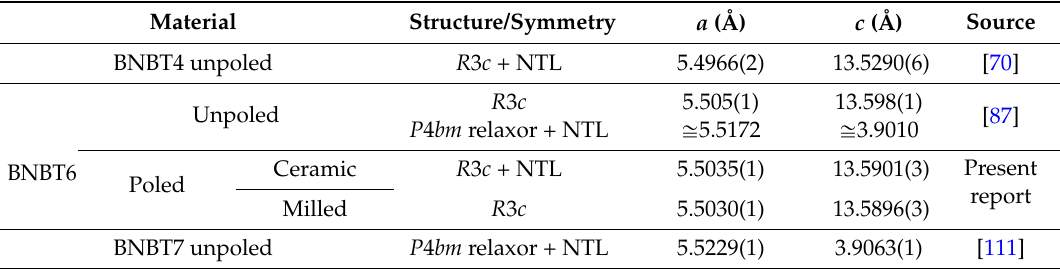
Table 4. BNBT x ( x = 4, 6, 7) space groups and lattice parameters.